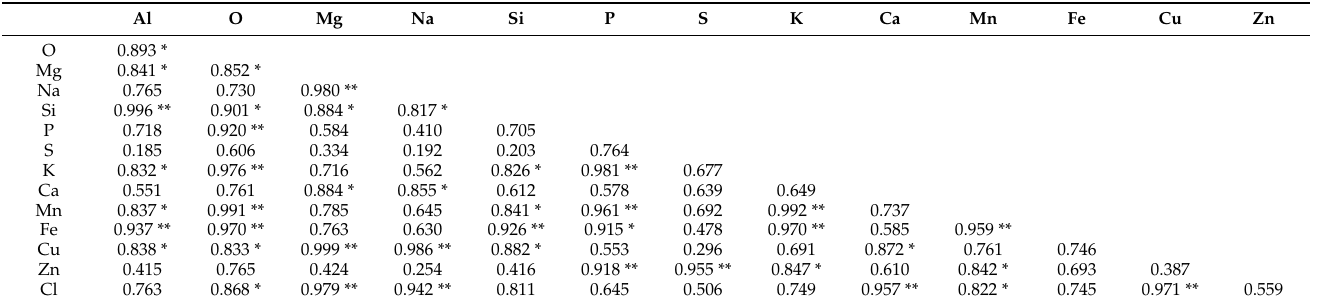
Table 3. Correlation among inorganic elements in